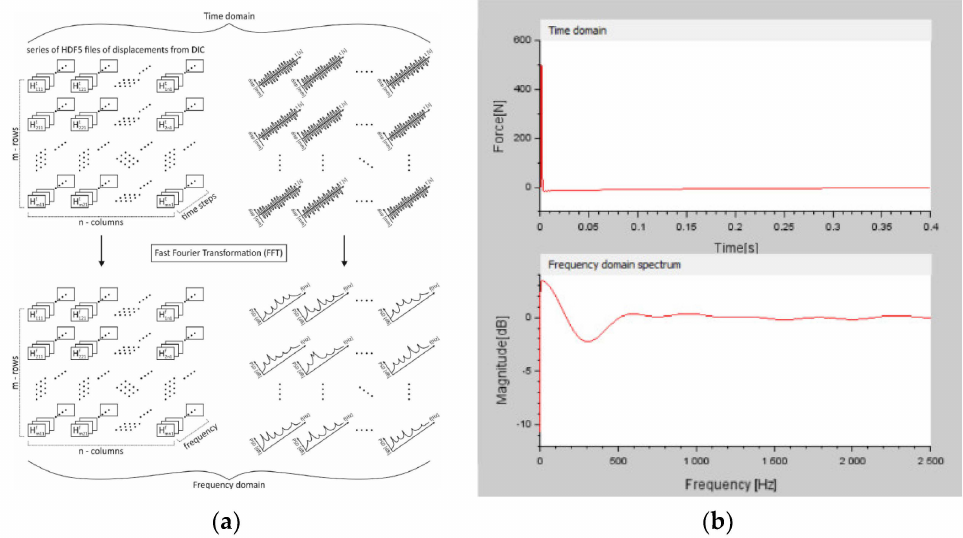
Figure 10. ( a ) Transformation of 3D displacement matrix from time domain to frequency spectrum; ( b ) excitation signal in time domain and frequency